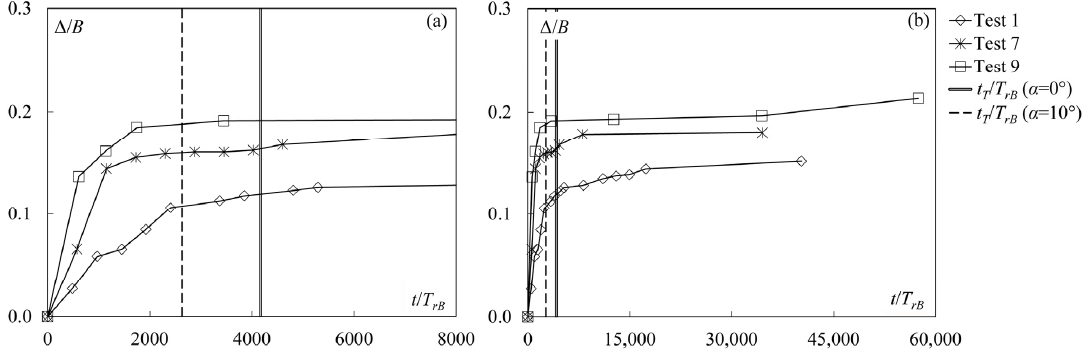
Figure 3. ∆ / B versus t / T rB for Test 1 ( Q = 0.0122 m 3 /s), Test 7 ( Q = 0.0179 m 3 /s), and Test 9 ( Q = 0.0144 m 3 /s) of Gaudio and Marion [1] pertaining to bed sills (for which we estimated 0 ◦ < α < 10 ◦ ), along with the vertical lines indicating the transition times calculated using Equation (3) with α = 0 ◦ and α = 10 ◦ for ( a ) t / T rB < 8000 (detailed view) and ( b ) total test